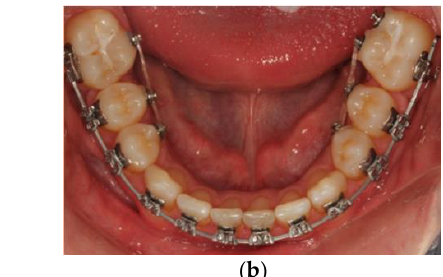
Figure 7. End-of-treatment intraoral photographs. Alignment, overbite, and overjet correction was achieved with fixed appliances in 18 months.